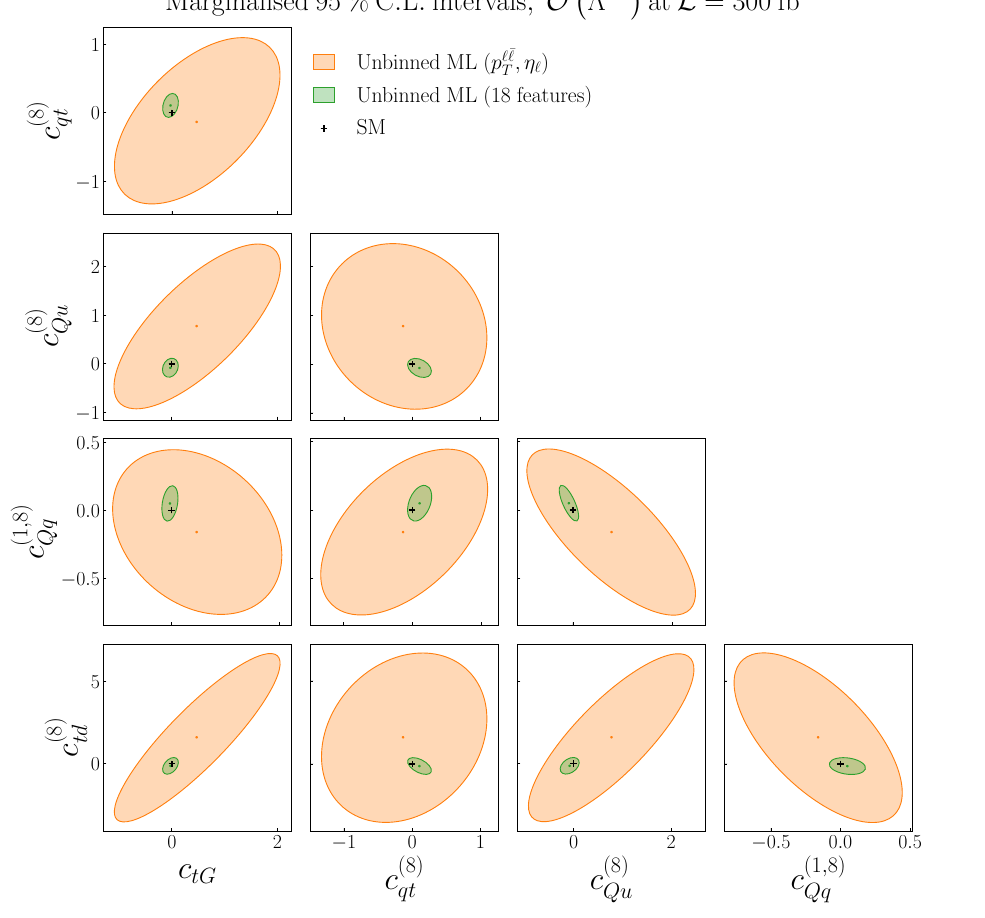
Figure 12. Same as figure 11 comparing the bounds on the EFT coefficients from the ML unbinned observables trained on ( p ‘ ¯ ‘ , η ‘ ) and on the full set of n k = 18 kinematic features listed in section 4.3, T see also figure